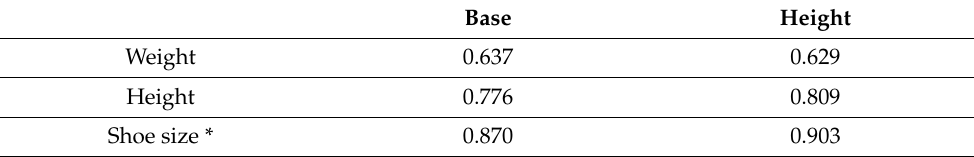
Table 2. Correlation between variables ( p < 0.05). * European shoe